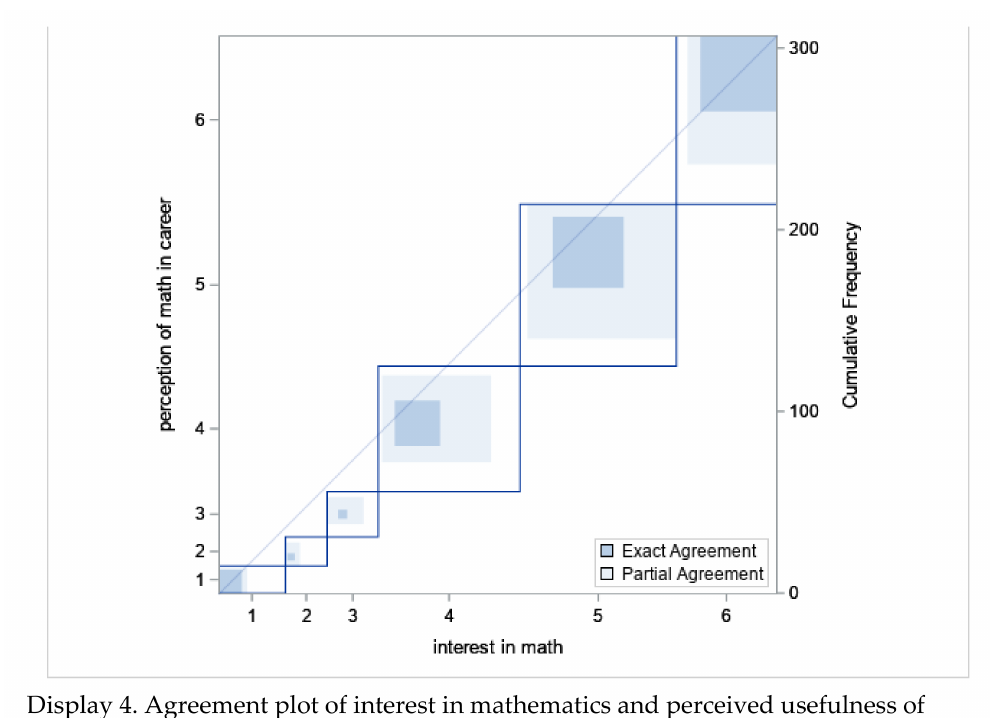
Figure 2. Agreement